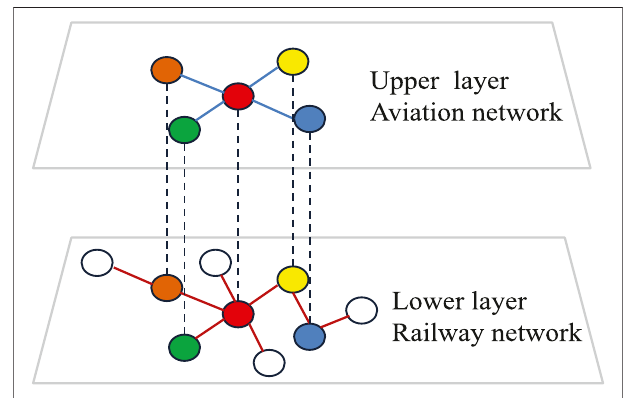
FIGURE 1 | Double-layer logistic network. The solid lines represent the transportation edges within one layer, and the dotted lines represent the coupling edges between two layers. Nodes with the same color represent the railway station and airport in the same